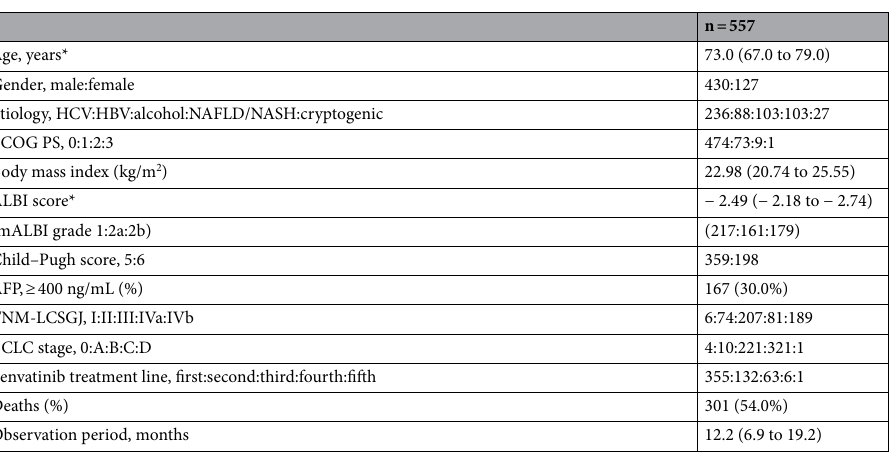
Table 1. Clinical features of all u-HCC patients. HCV hepatitis C virus, HBV hepatitis B virus, NAFLD : non- alcoholic fatty liver disease, NASH non-alcoholic steatohepatitis, ECOG PS Eastern Cooperative Oncology Group performance status, ALBI score albumin-bilirubin score, mALBI grade modified ALBI grade, AFP alpha-fetoprotein, TNM LCSGJ 6th tumor node metastasis stage by Liver Cancer Study Group of Japan 6th edition, BCLC stage Barcelona Clinic Liver Cancer stage. *Median (interquartile range).